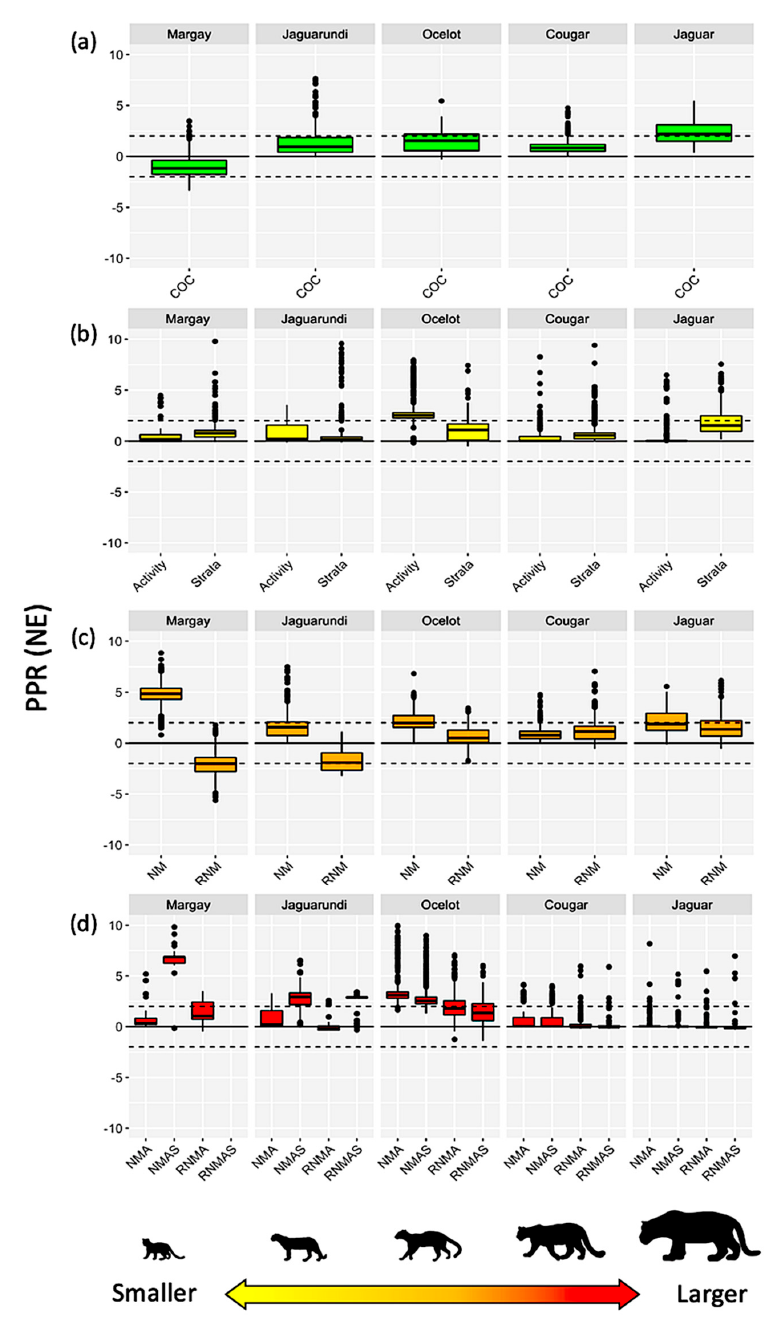
Figure 2. Normalized error (NE) of the predator–prey ratio for the nine models evaluated at the predator species level for each predator species, where the x -axis shows the different predator species and models and the y -axis shows the normalized errors for ( a ) co-occurrence model, ( b ) spatiotemporal models, ( c ) body size models and ( d ) saturated models. The upper horizontal dashed line indicates the reference value plus two standard deviations, while the lower horizontal dashed line indicates the reference value minus two standard deviations and the continuous horizontal line indicates the reference value. See Table 1 and the methods for the model definitions. Cat silhouettes are from PhyloPic (phylopic.org) and represent the evaluated species.